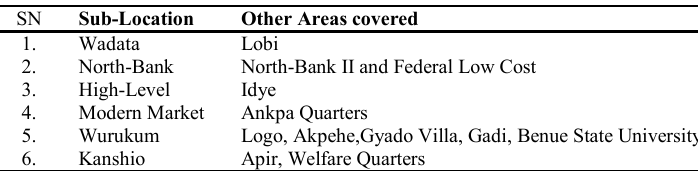
Table 2: Study city sub-locations and other areas covered